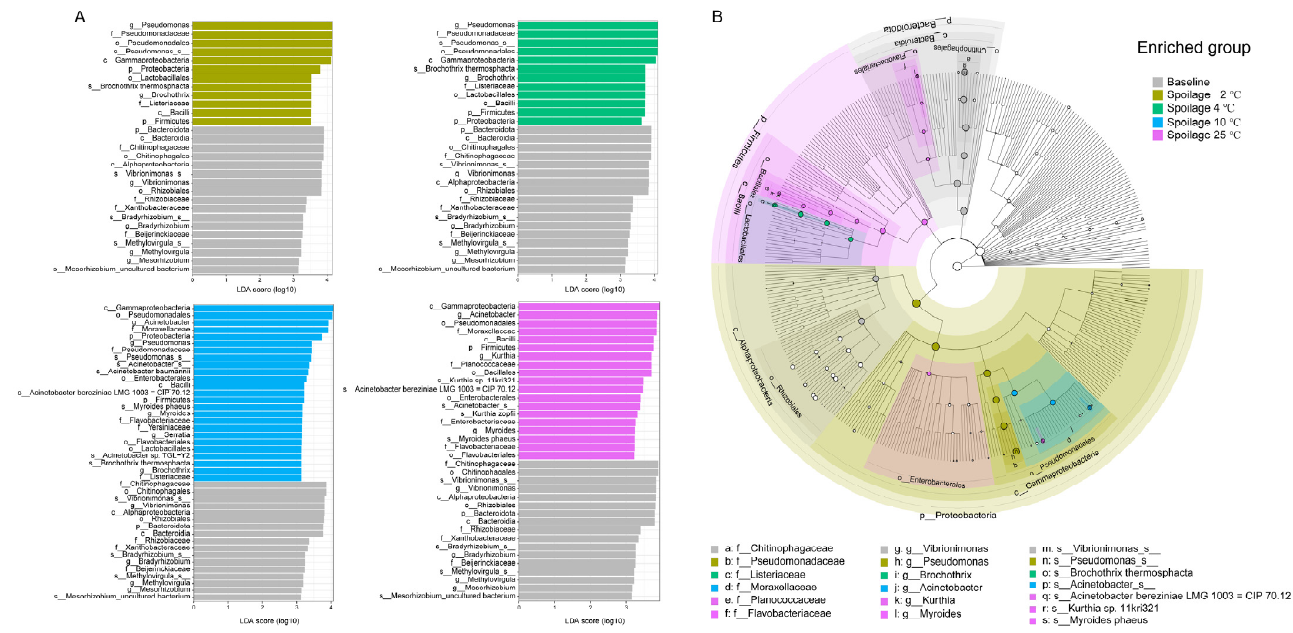
Figure 2. Linear discriminant analysis effect size (LEfSe) analysis of the microbial composition in pork meat. ( A ) Histogram of the LDA scores reveals the most differentially abundant taxa between fresh pork meat and spoiled pork meat stored at each temperature condition, respectively. Only features with least discriminant analysis (LDA) values > 2 and Padj values < 0.05 are displayed. p, phylum; c, class; o, order; f, family; g, genus; s, species. ( B ) Cladogram using the LEfSe method, indicating the phylogenetic distribution of bacteria in fresh and spoiled pork